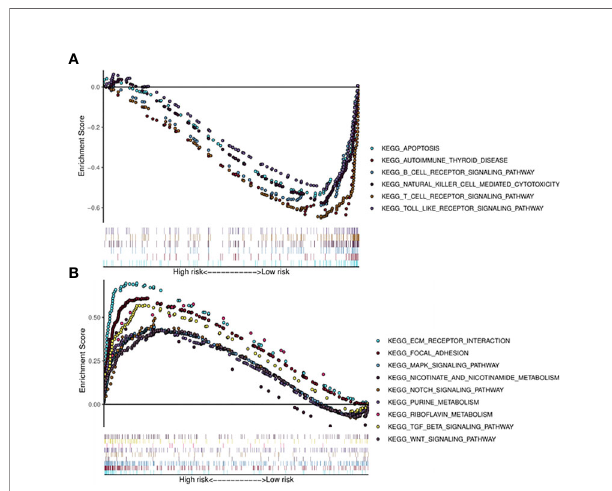
FIGURE 7 | Risk score correlated enrichment gene analysis with multi- GSEA. HPV+ group: (A) ; HPV- group: (B) .